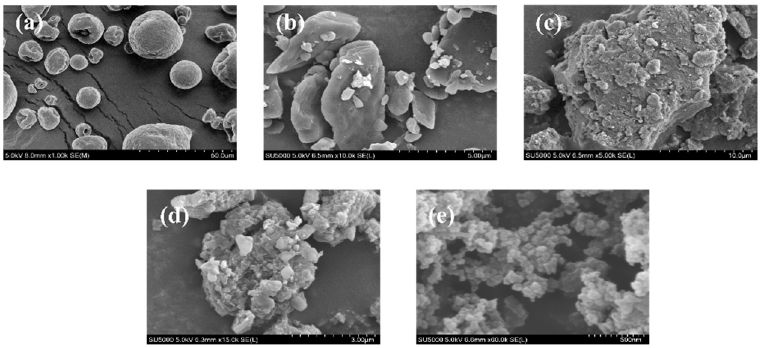
Figure 5. ( a ) SEM image of BX. ( b ) SEM image of AD. ( c ) SEM image of FA-BX/AD. ( d ) SEM image of BA F G 2 . ( e ) SEM image of BA F G 2 nanoparticle.